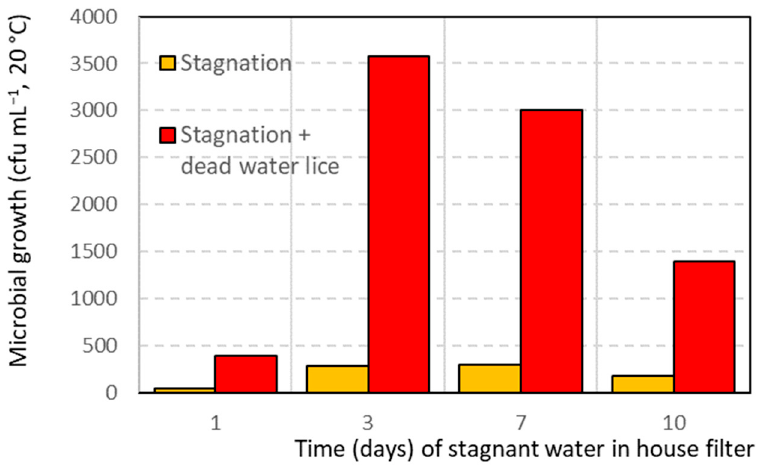
Figure 6. Microbial contamination of house filters with stagnant water without dead water lice (orange) and stagnant water with 5 dead water lice (red) as colony forming units (cfu).